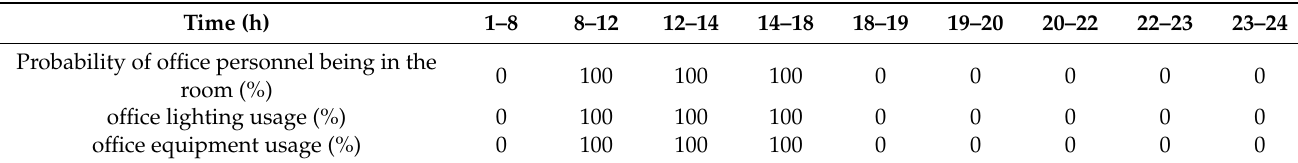
Table 5. Setting of design parameters for office building (type 3).